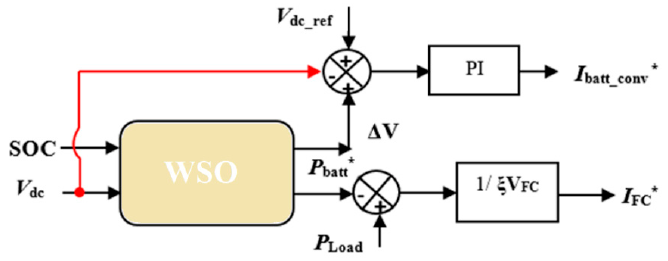
Figure 9. Optimized EEMS-based WSO.